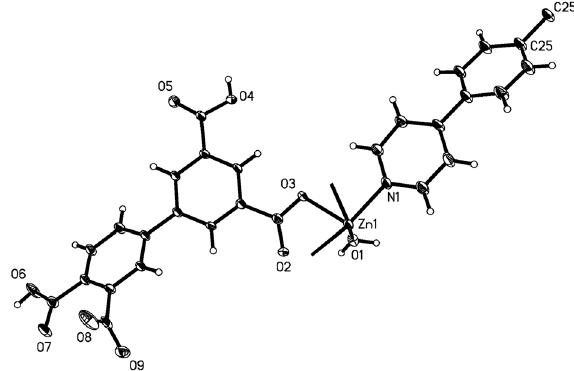
the list of the atoms including atomic coordinates and displacement parameters.